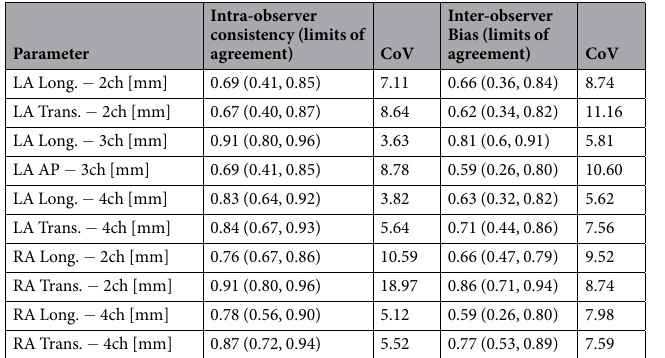
Table 9. Inter- and intra-variability of the atrial dimensions (n = 135). CoV, coefficient of variation. LA, left atrium; RA, right atrium; Long., Longitudinal dimension; Trans, Transverse dimension; AP, Antero-posterior dimension; 2ch, 2-chamber view; 3ch, 3-chamber view; 4ch, 4-chamber